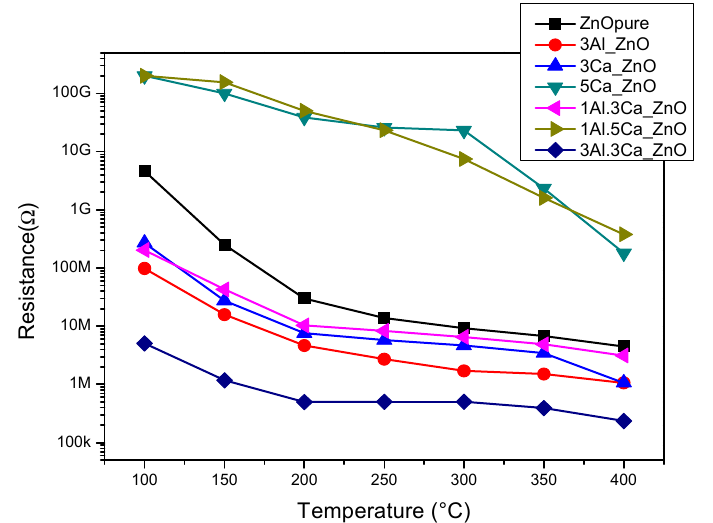
Figure 4. Baseline resistance in dry air of the pure and doped-ZnO sensors in the temperature range from 100 to 400 °C.